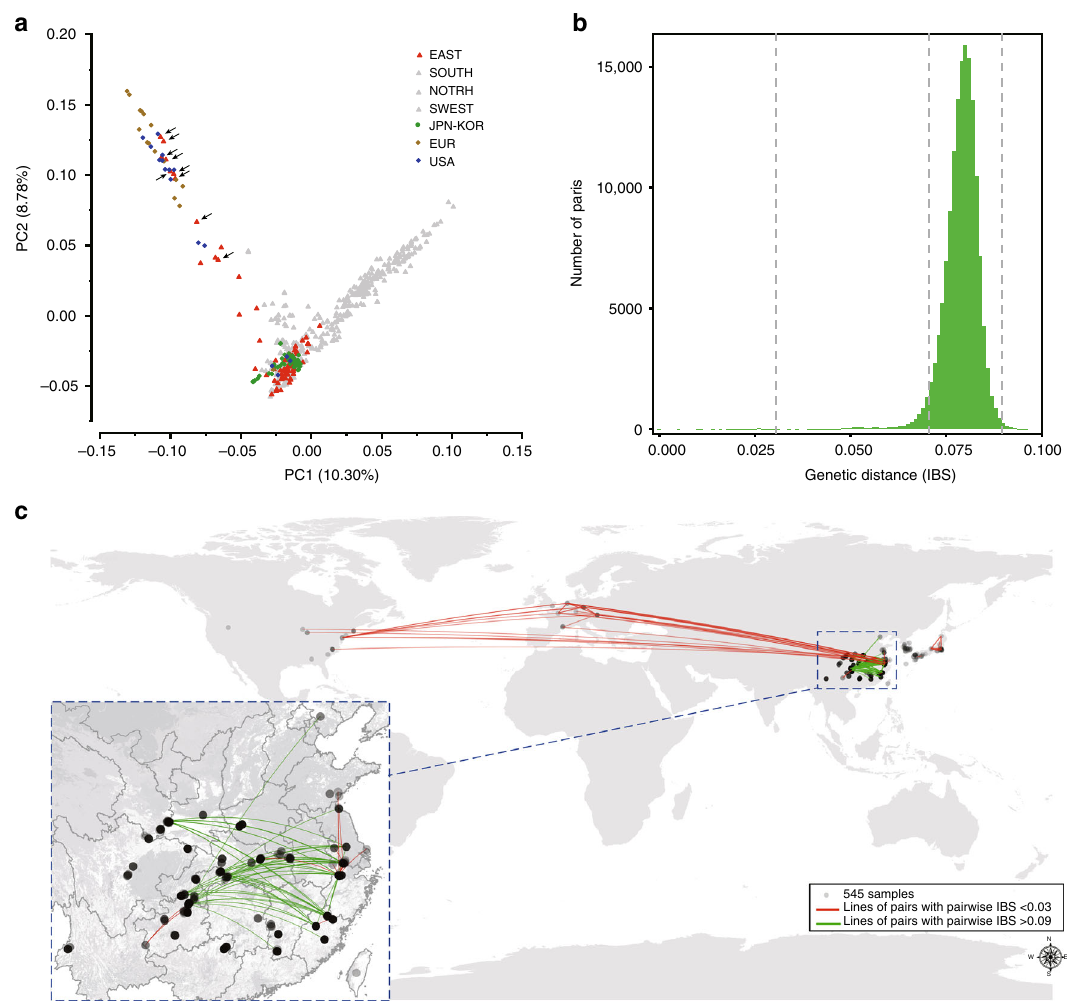
Fig. 3 Genetic and geographic distances between all samples. a Principal component analysis of global samples. Triangles indicated by black arrows are the samples containing more than 50% of a rare genetic component (blue in Fig. 1b). This component is widespread in the European and American samples. b Distribution of pairwise identity-by-state (IBS) genetic distances, with three cutoffs indicted by vertical dashed lines. The map image was derived from ArcGIS. c Geographic locations of 545 global samples, showing the pairs with the shortest genetic distance (IBS < 0.03, connected by red lines) and pairs with the longest genetic distance (IBS > 0.09, connected by green lines). All the pairs without a line connection have the IBS values between 0.03 and 0.09. Source data are provided in a Source Data fi